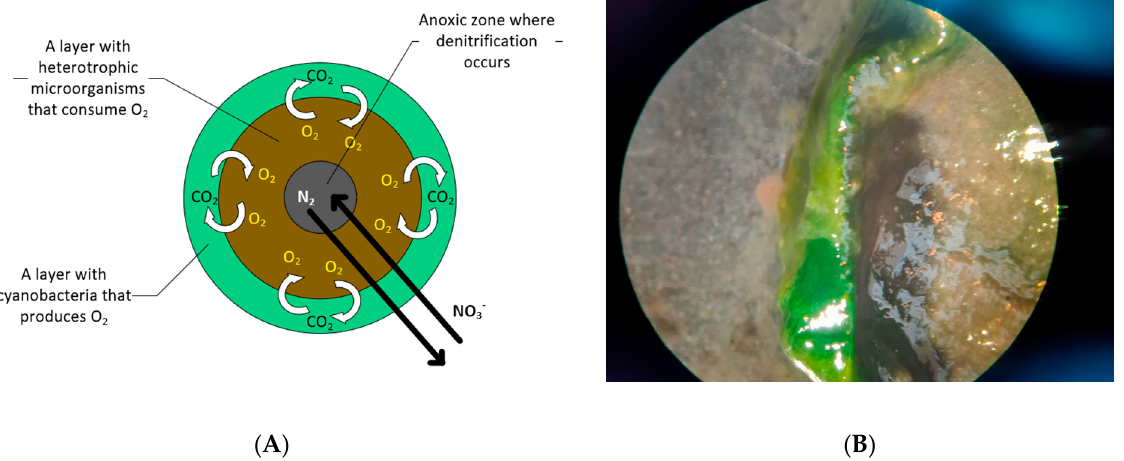
Figure 4. A scheme of: ( A ) an OPG structure, based on [31,48] and ( B ) stereoscopic image of a granule obtained through static cultivation (own study).